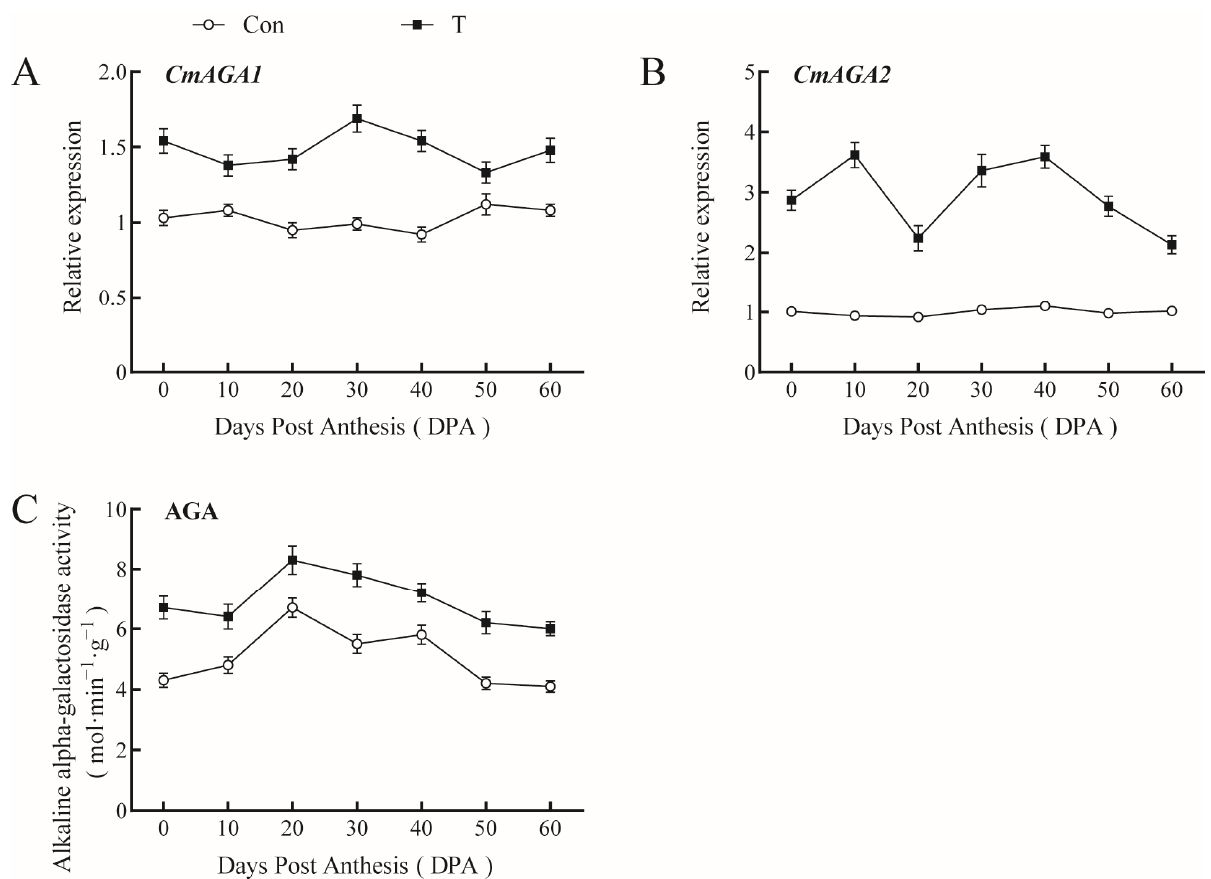
Figure 7. Effect of NAA and EBR on gene expression and activity of alkaline α -galactosidase (AGA) in giant pumpkin fruits. ( A , B ), Relative expression levels of CmAGA1 and CmAGA2 ; ( C ) activity of AGA.